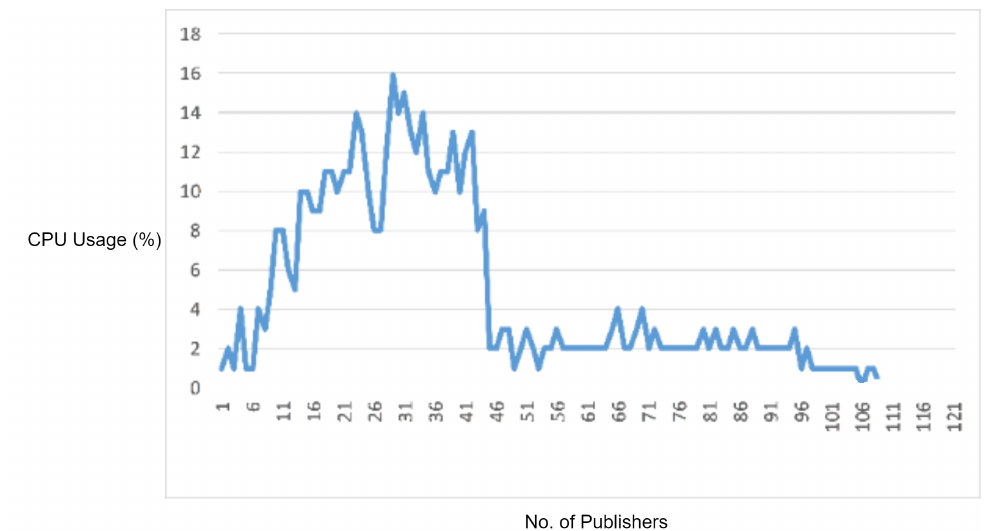
Figure 15. CPU Usage captured while performing MQTT DoS attack when IDS Rules are